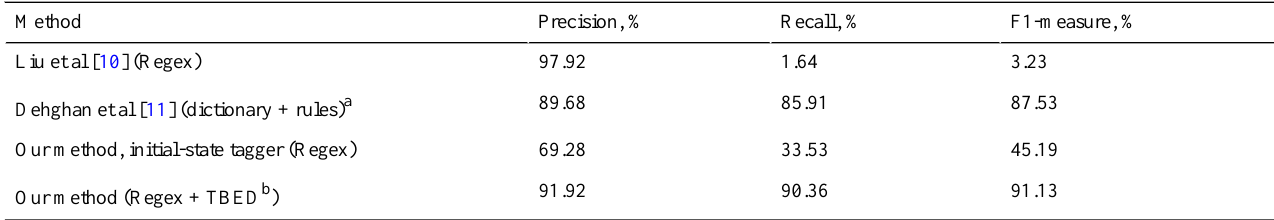
Table 5. Results of rule-based taggers (i2b2 categories, strict entity matching).